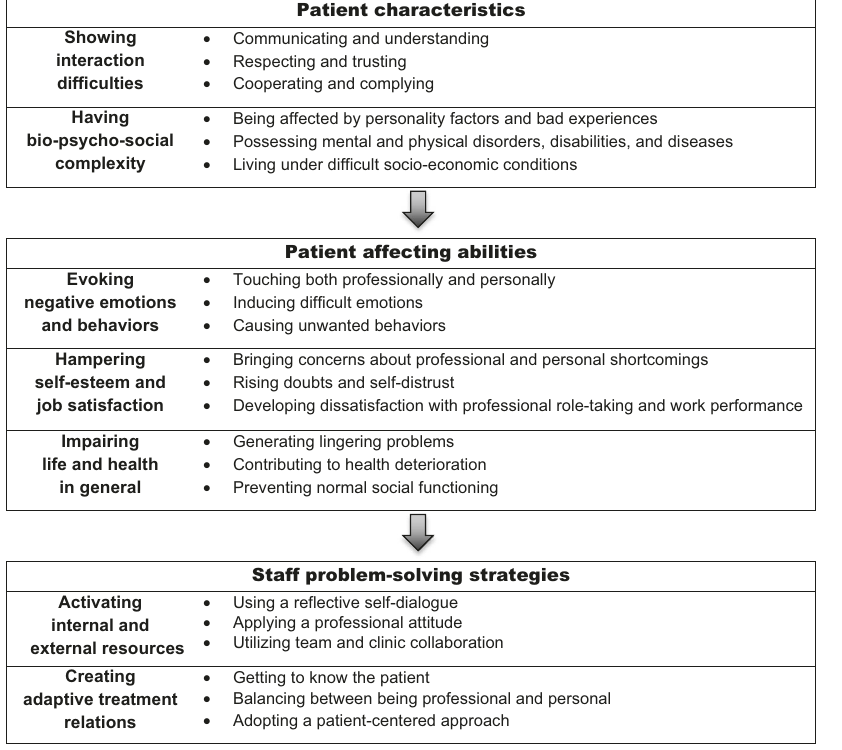
Fig. 1 Dental staff ’ s experiences of “ dif fi cult ” dental patients. A grounded theory hierarchy of patient characteristics, patient affecting abilities, and the staff ’ s problem-solving